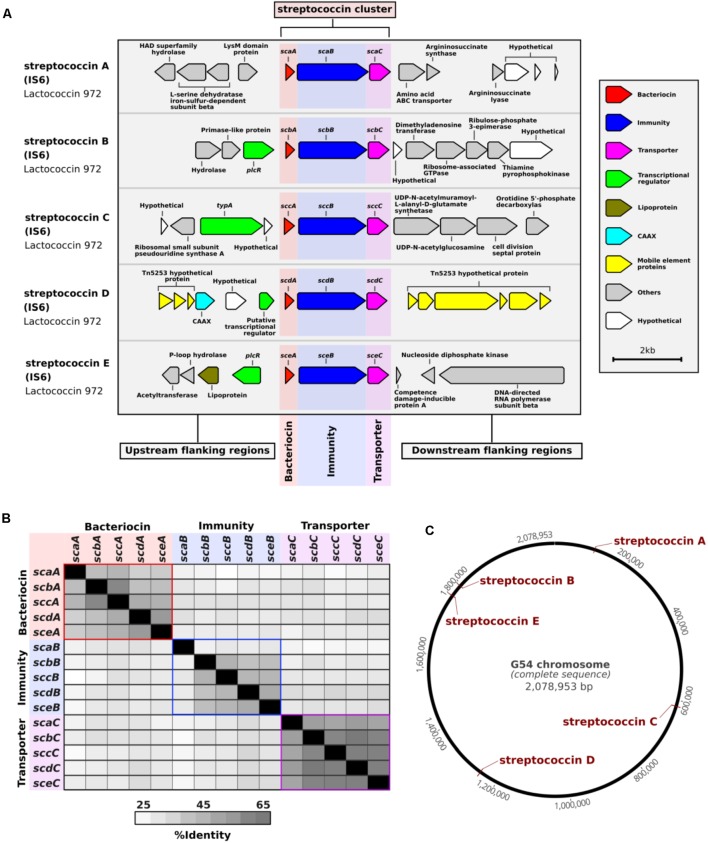
Streptococcin bacteriocins discovered among a large collection of pneumococcal genomes. (A) A schematic representation of each streptococcin cluster and their flanking regions is depicted. The coding regions were derived from the genome of pneumococcal strain IS6, which harbors five different complete streptococcin clusters. (B) A distance matrix of the nucleotide sequence identity shared between genes of different streptococcin clusters found in pneumococcal strain IS6 is shown. (C) Schematic of the finished genome of pneumococcal strain G54 with the locations of the five streptococcin clusters highlighted in red.